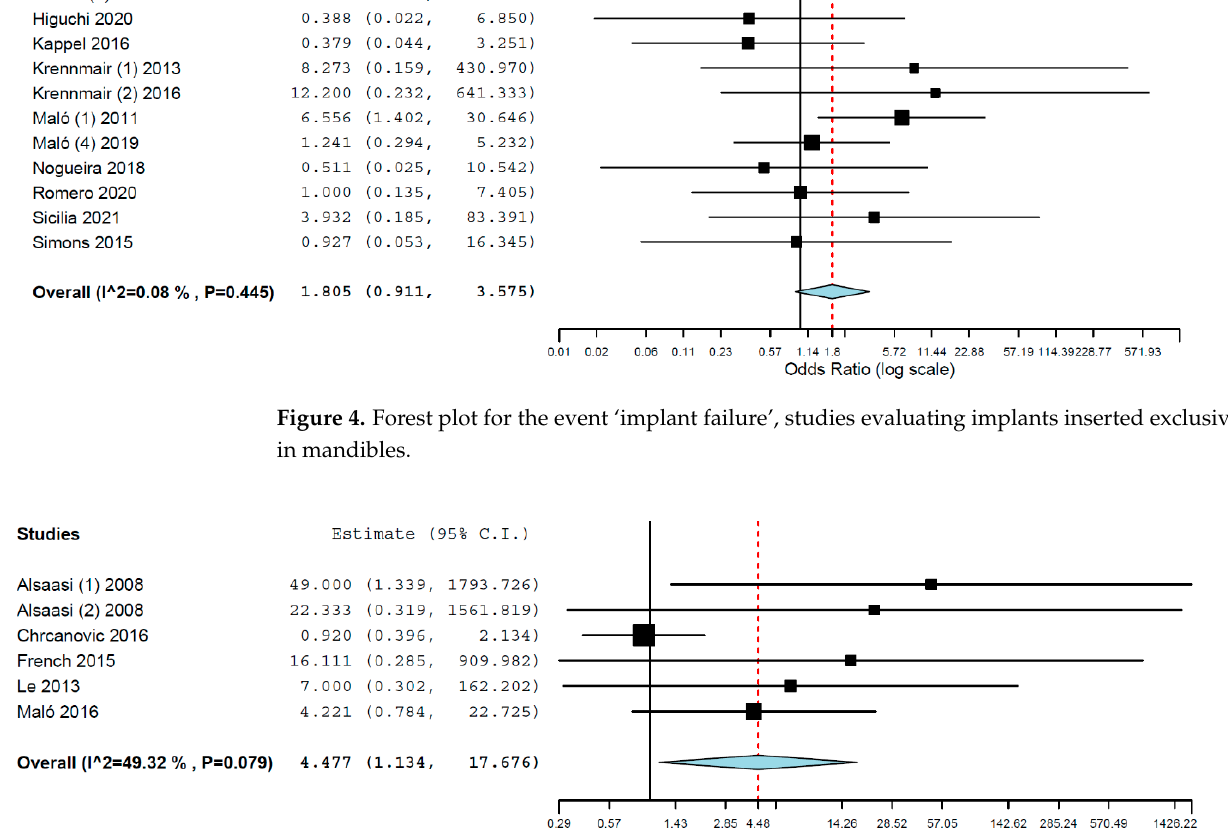
Figure 5. Forest plot for the event ‘implant failure’ between diabetes mellitus type I and type II. The MD of MBL between the groups was 0.776 mm (95% CI, 0.090, 1.461, standard error 0.350, p = 0.027) ( τ 2 = 1.217, Chi 2 = 6083.123, I 2 = 99.852, p < 0.001) (Figure 6), meaning that implants placed in diabetic patients presented a mean 0.776 mm higher MBL than the implants placed in non- diabetic patients. The difference was statistically significant.